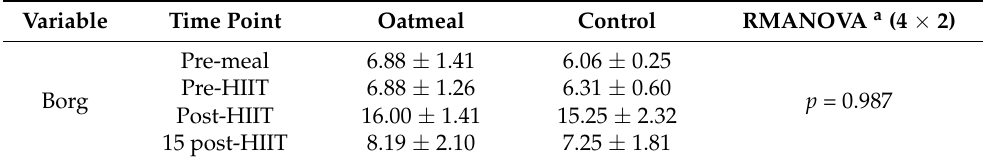
Table 4. Changes in the Borg Scale in the oatmeal group and control group from pre-meal to 15 post-HIIT. Statistical differences were measured using